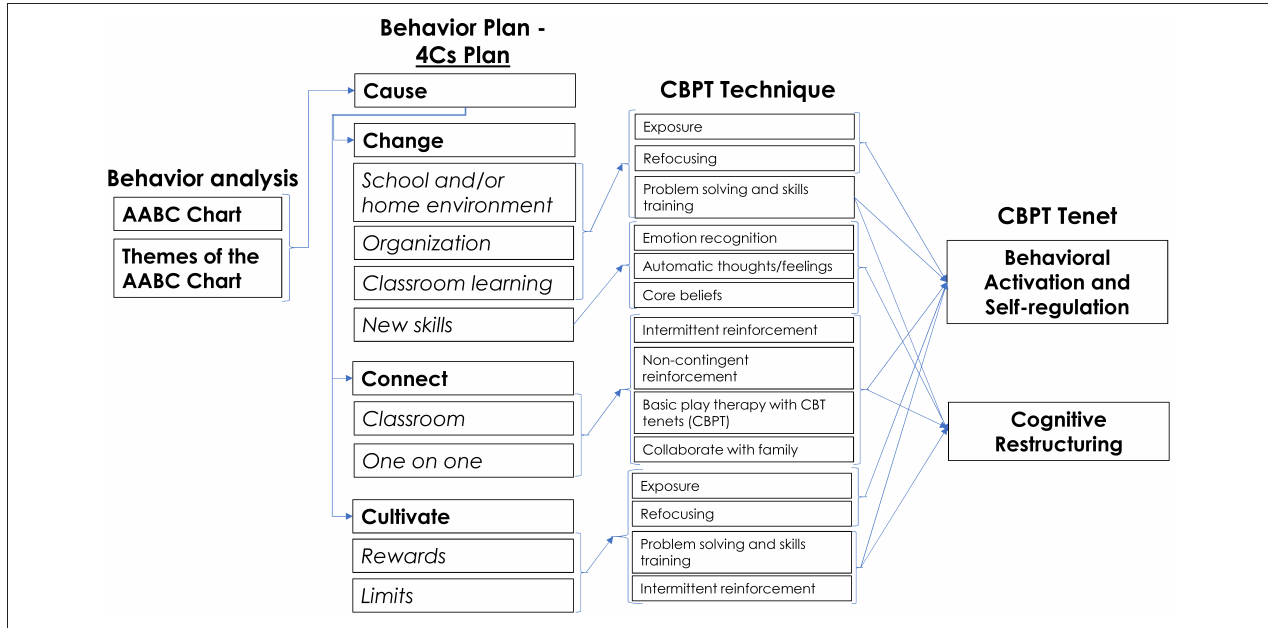
FIGURE 1 | Mapping out CBPT tenets and techniques within